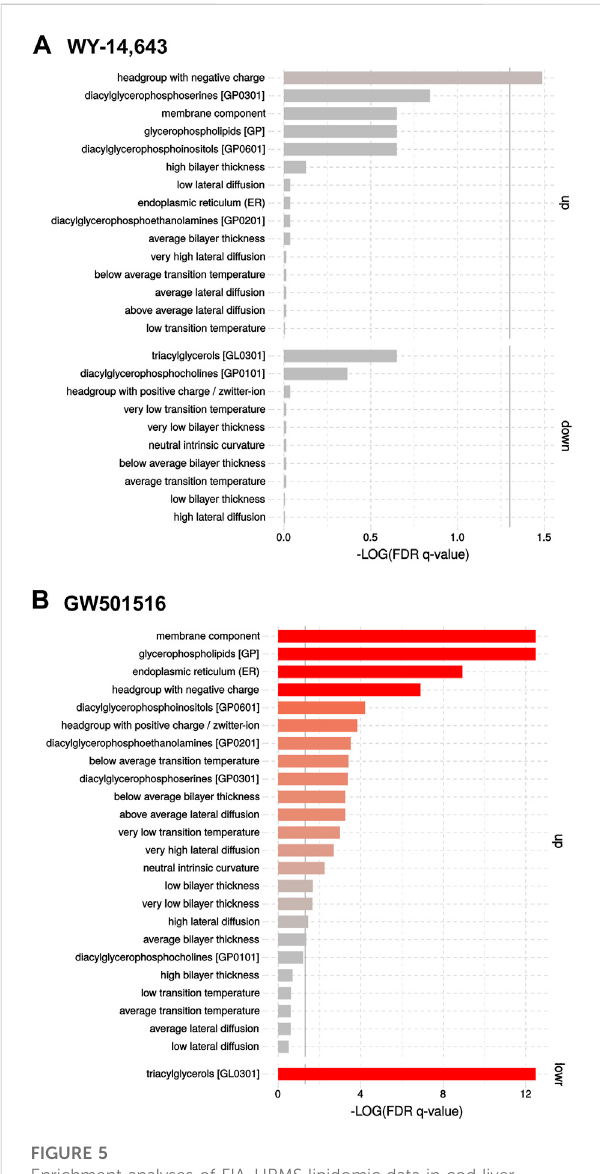
Enrichment analyses of FIA-HRMS lipidomic data in cod liver microsomes following treatment with the high dose of (A) WY- 14,643 and (B) GW501516. The analyses were performed on normalized targeted lipidomics data, using the LION/web tool (Molenaar et al.,